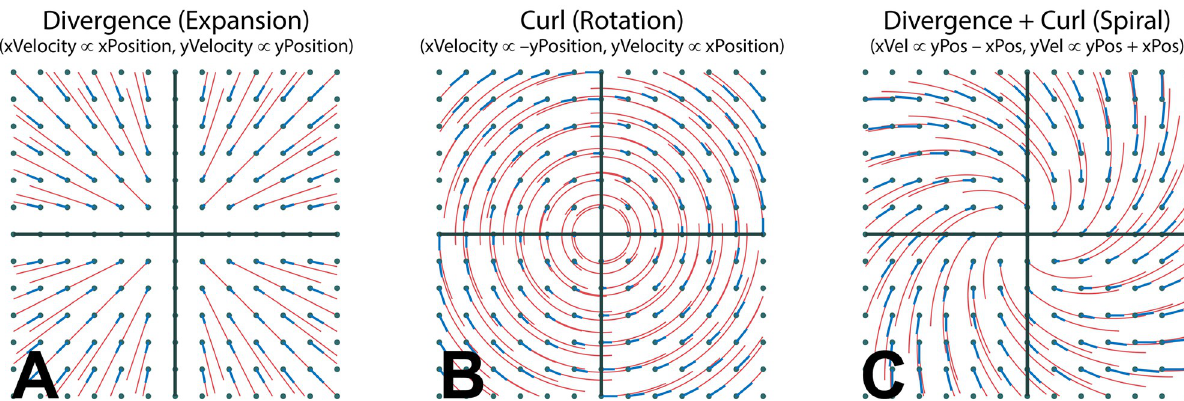
Fig 11. Divergence, curl, and spiral flow patterns. Canonical examples of Divergence (expansion), Curl (rotation), and the combination of divergence and curl (which produces spiral patterns. In the case of flowfield showing pure expansion (A—positive divergence), flow velocity is proportional to position on the grid—e.g. a step in the positive X direction results in an increase in X velocity (and similar for the Y direction). In the case of pure rotation (B—Curl) flow velocity increases in the orthogonal direction of the step—so a step in the positive X direction yields an increase velocity in the positive Y direction (for clockwise rotation/positive curl) or the negative Y direction (for counter clockwise rotation/negative curl). Summing the velocities of the divergence and curl flow fields results in spiral motion (C).